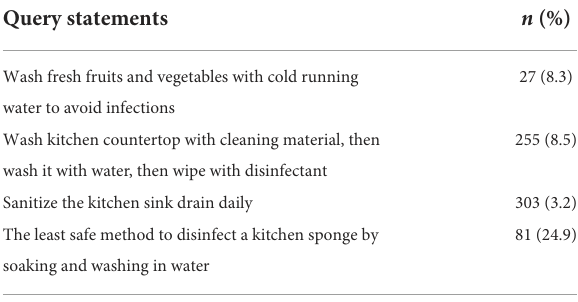
TABLE 7 Query statements and responses a of “cleaning and sanitation” domain ( n =